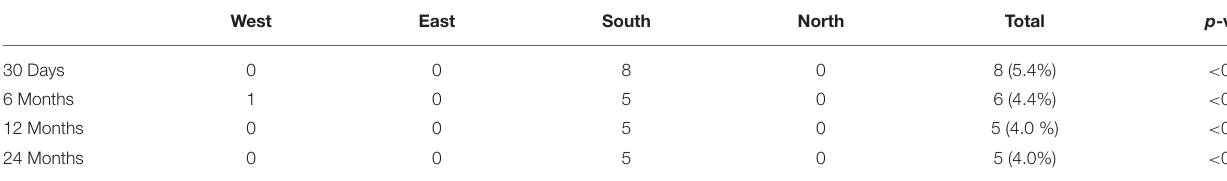
TABLE 8 | Geographical distribution of reinterventions.